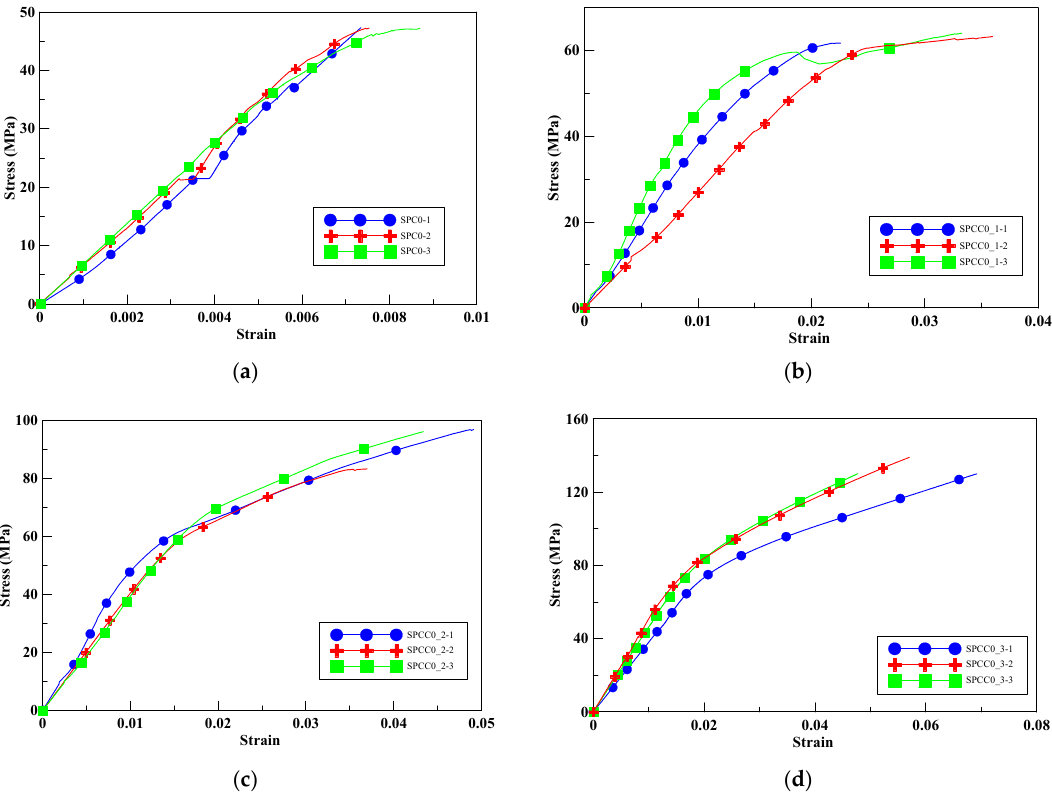
Figure 4. Stress–strain curves of specimens ( a ) SPC0, ( b ) SPCC0_1, ( c ) SPCC0_2, and ( d ) SPCC0_3.